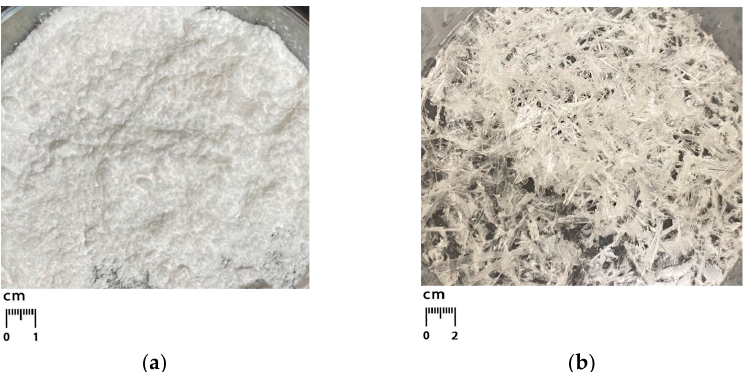
Figure 1. Appearance of synthesized zinc methionine Zn(Met) 2 ( а ) and crystallized zinc methionine Zn(Met) 2 (SO 4 ) x •nH 2 O ( b ) complexes. Zn(Met) 2 (SO 4 ) x · nH 2 O ( b )